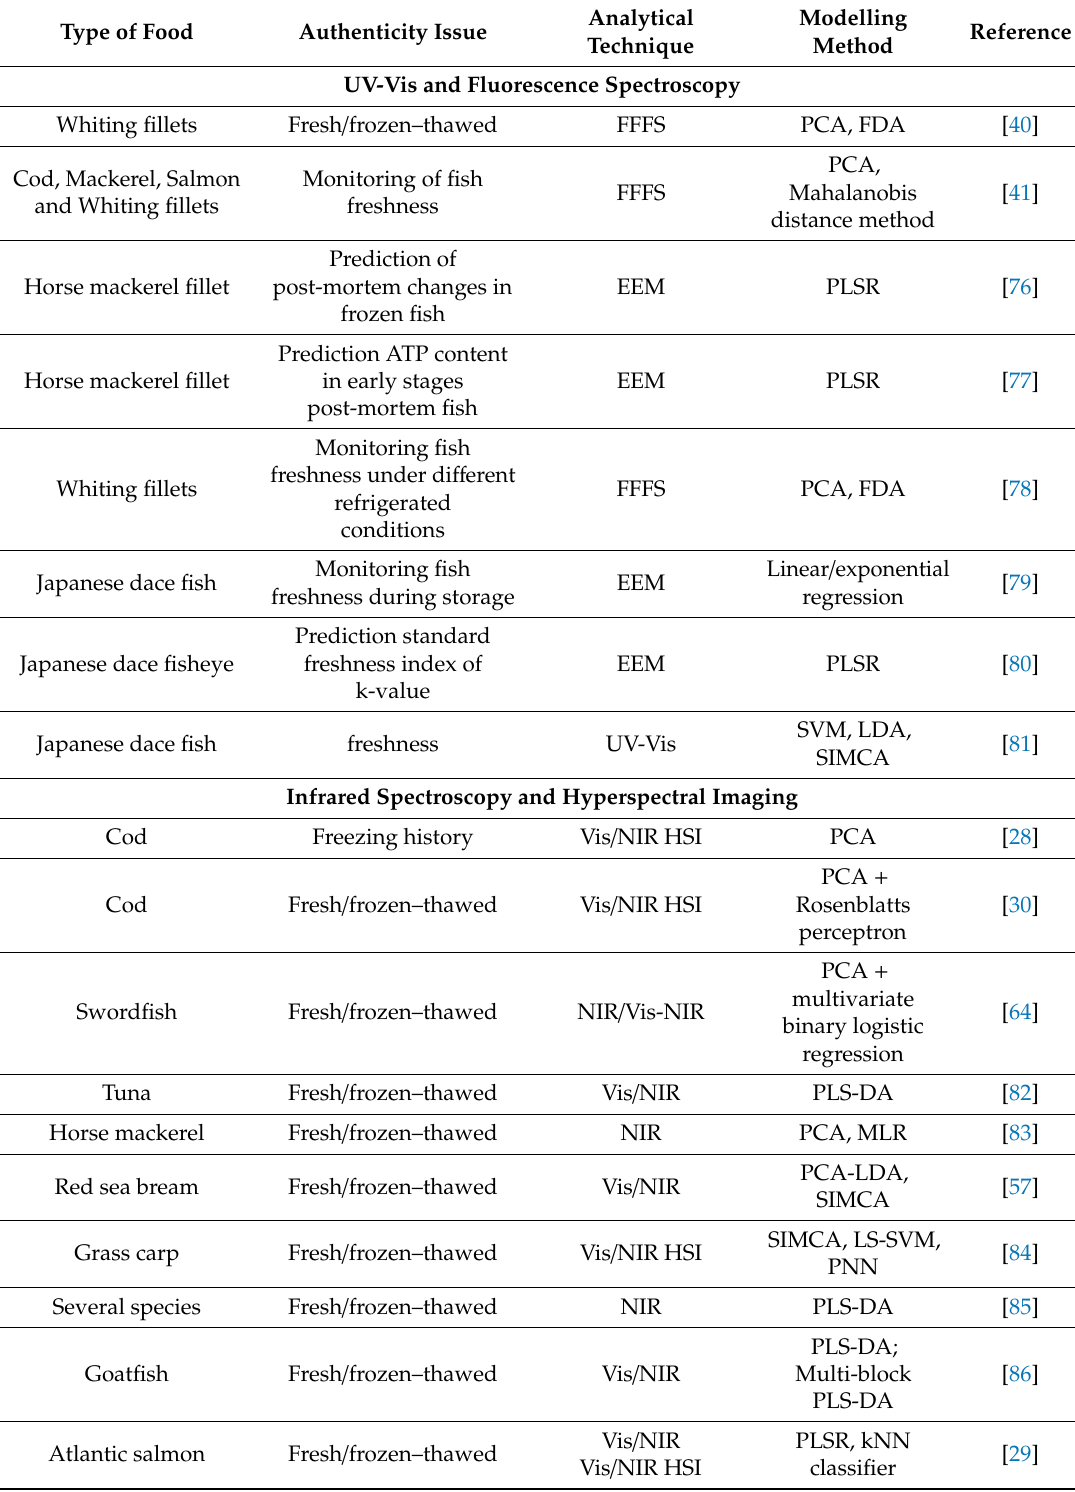
Table 2. Further application of spectroscopic techniques for the assessment of quality changes in fish and fishery products during freezing, frozen storage, and